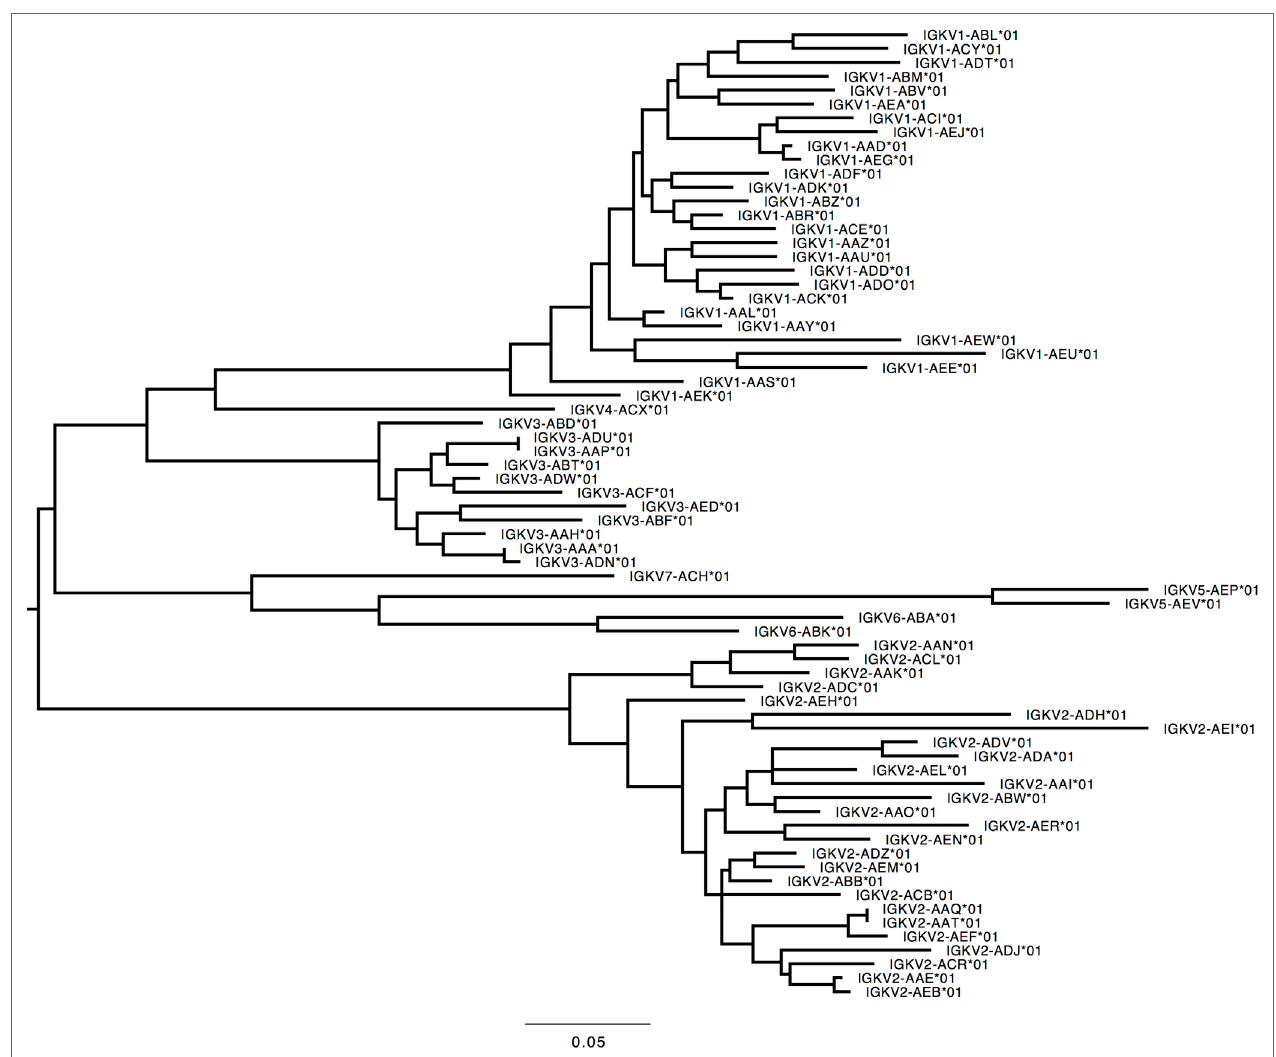
FigUre 5 | Maximum likelihood phylogenetic tree of the rhesus IGKV functional genes, based on the final immunoglobulin allele library.